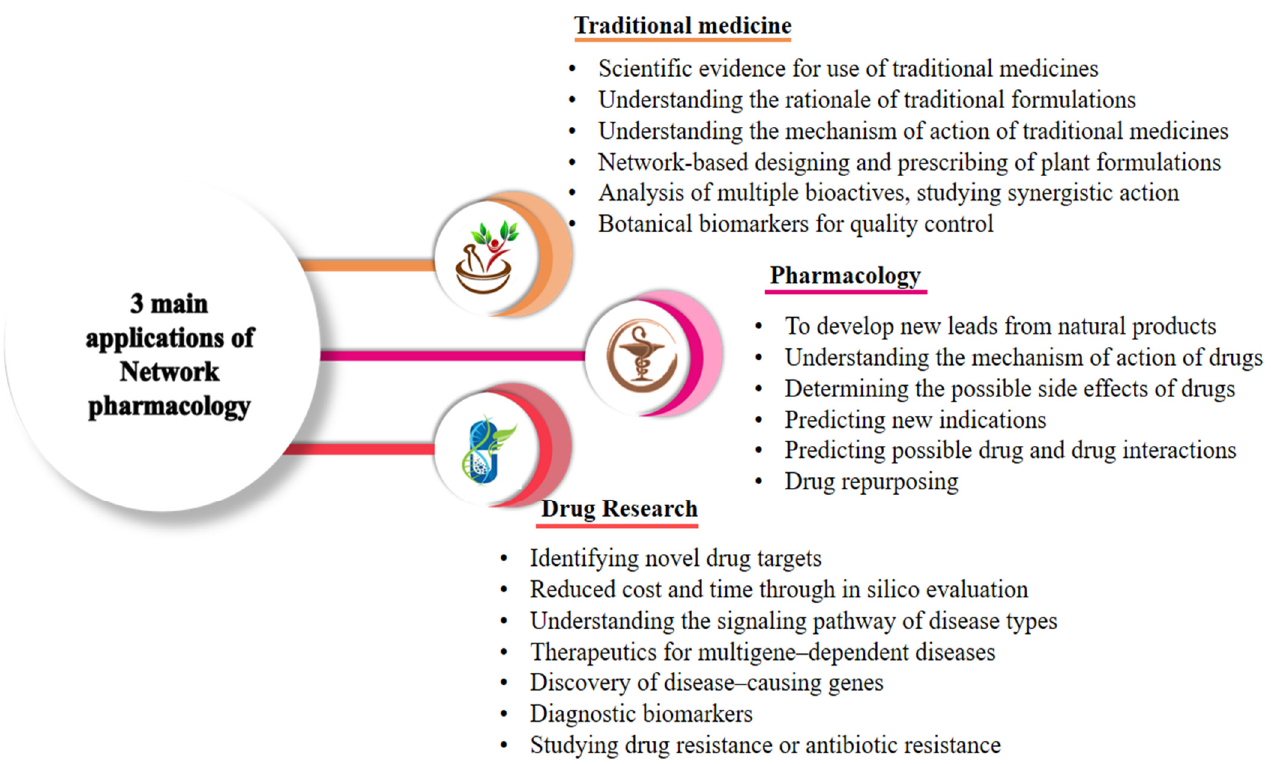
Figure 3. Three main application of network pharmacology in health biology for exploring the basic pharmacological effects of drugs on diseases and their mechanisms. pharmacological effects of drugs on diseases and their